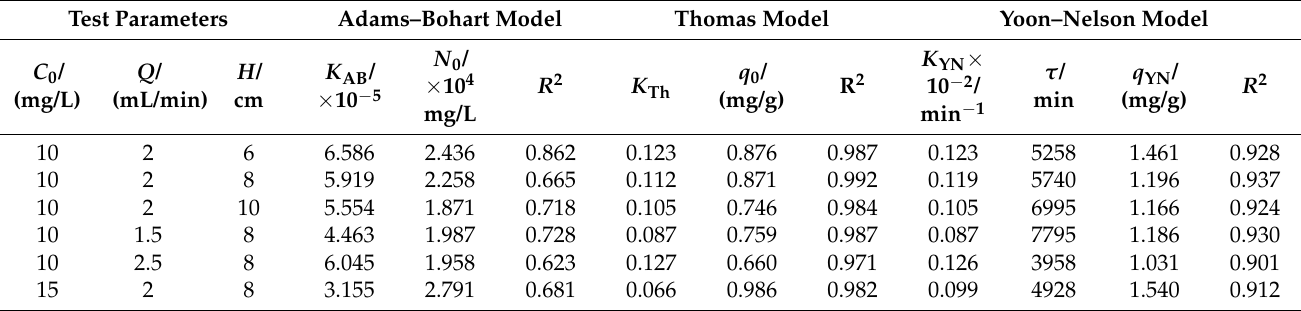
Table 4. Model parameters for the adsorption of Mn 2+ on